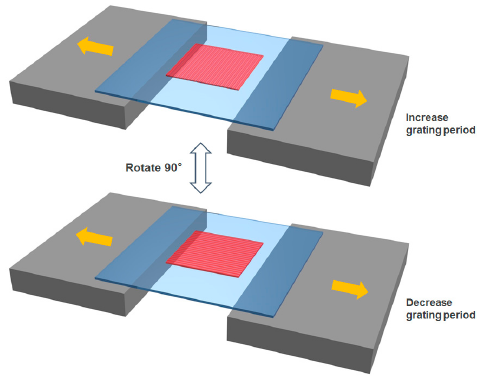
Figure 1. Schematic design of the tunable DFB film dye laser device and the two-directional tuning strategy. The laser wavelength is adjusted by stretching the grating in two directions.